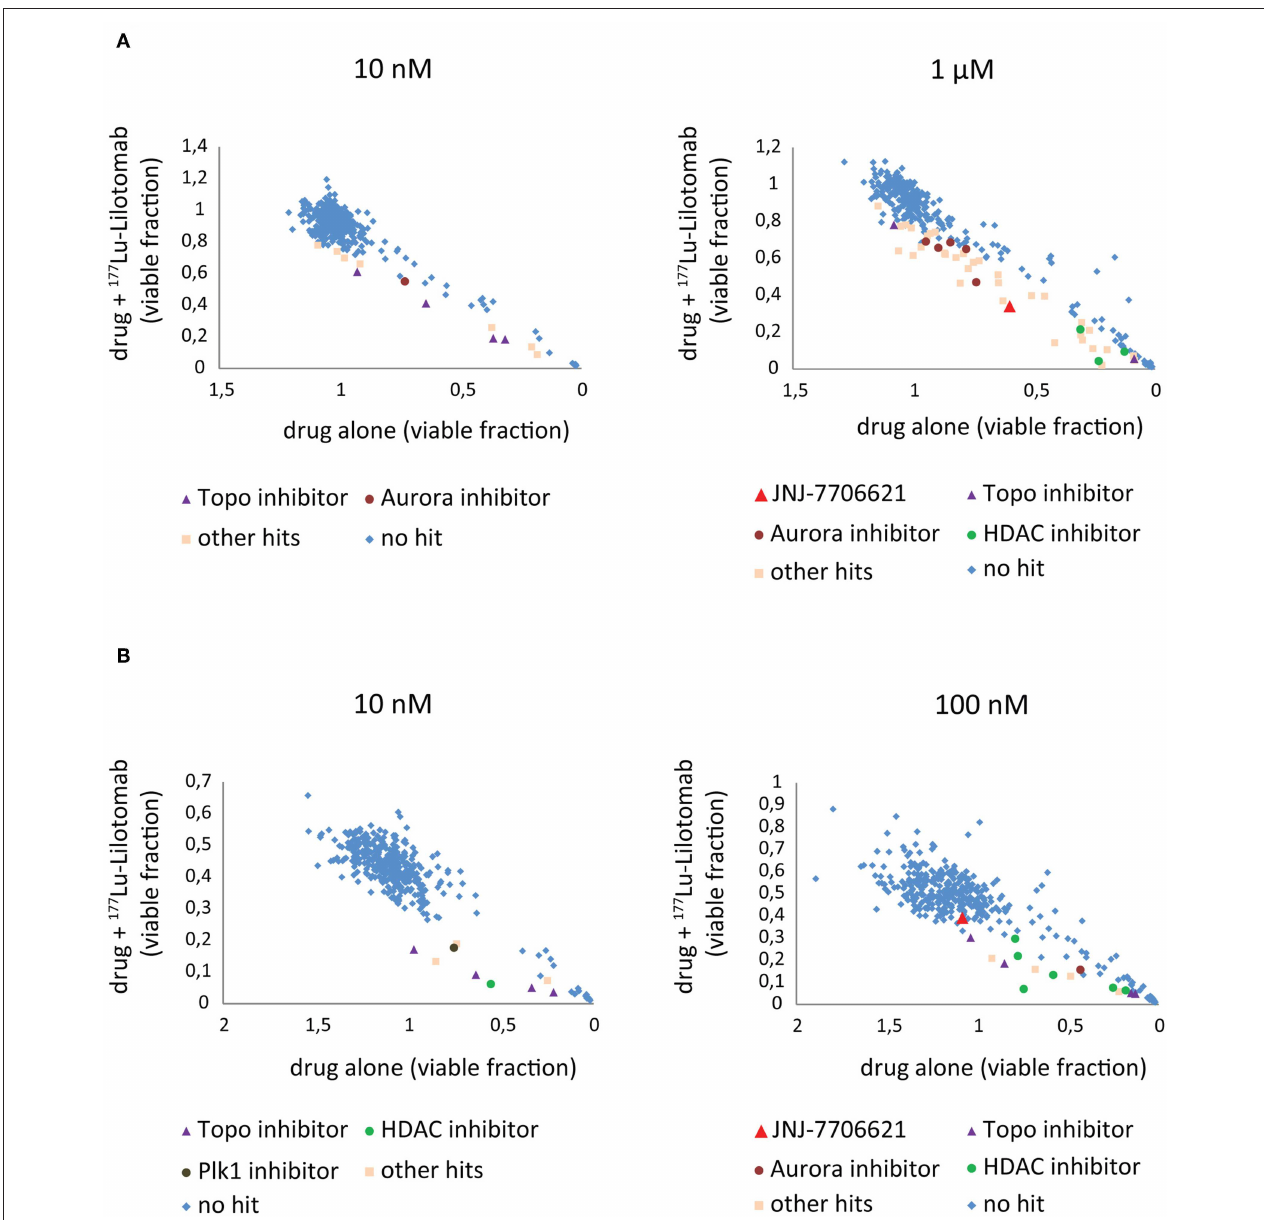
FIGURE 3 | Combination screen for compounds reversing 177 Lu-lilotomab satetraxetan resistance in DLBCL. Cells were treated as explained in Figure 2 . The fraction of viable cells relative to untreated control at day 5 has been plotted for cells treated with drug alone (x-axis) against cells treated with drug combined with 177 Lu-lilotomab satetraxetan (y-axis) for the two concentrations of drugs tested in each cell line. (A) U-2932 and (B) RIVA. In blue are drugs excluded as hits by our statistical criteria (See Figure 2 ). Enriched hits are specified with name of common target and are in separate colors [purple triangles: topoisomerase inhibitors, burgundy circles: aurora kinase inhibitors (including Alisertib) and green circles: histone deacetylase inhibitors]. In red is the pan-CDK1/2 and AuroraA/B inhibitor JNJ-7706621 and in brown the Plk1 inhibitor GSK461364. In light pink are all other hits.